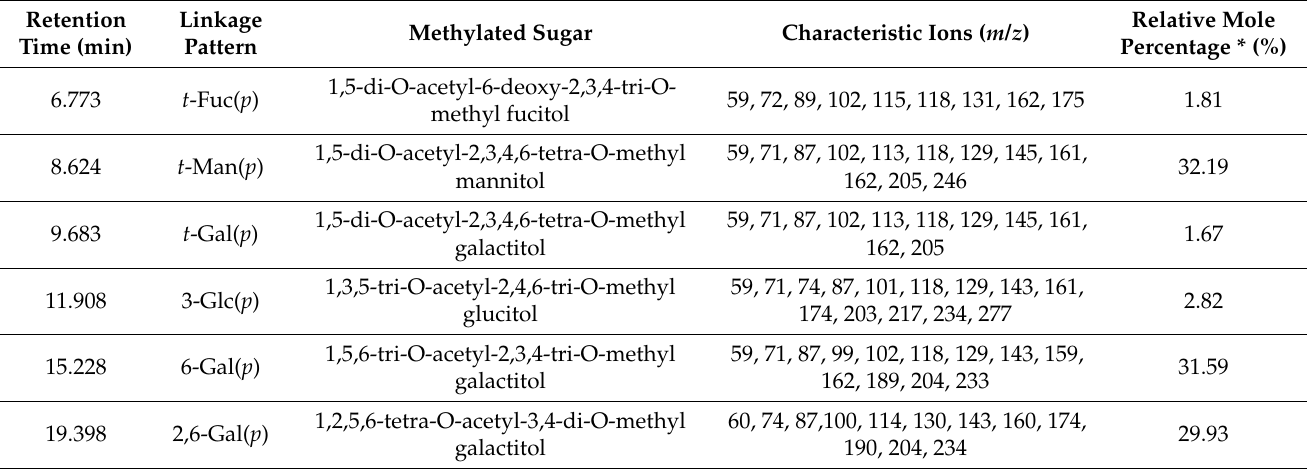
Table 1. Methylation analysis of PAPS1.